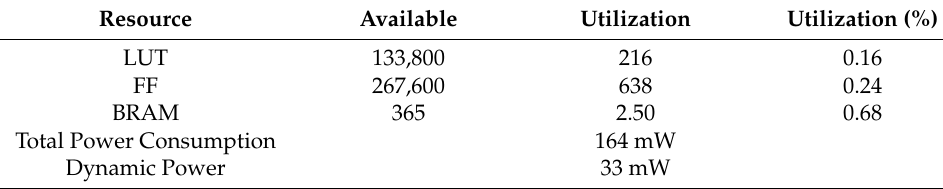
Table 3. Resources usage and power consumption of one TDC channel.